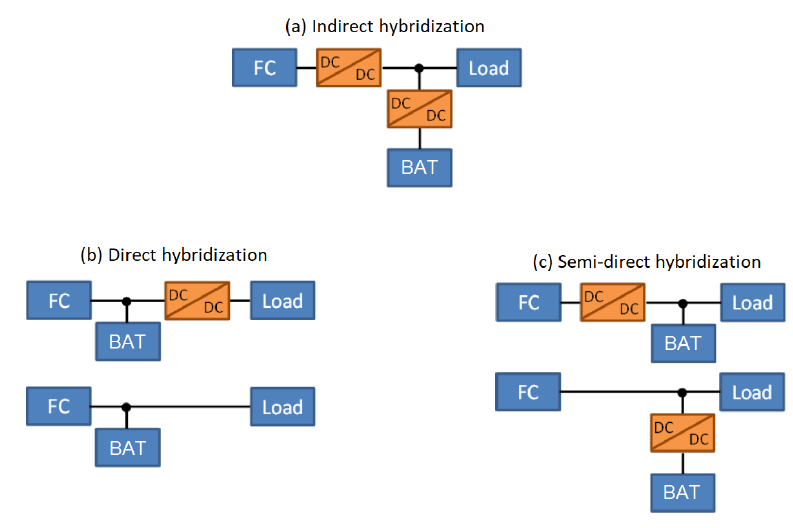
Figure 1. Types of connection of a fuel cell–battery hybridization.